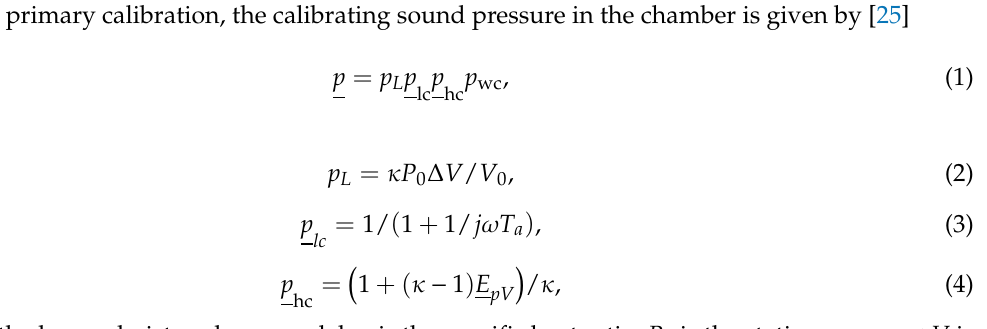
Figure 1. ( a ) The calibration characteristics of the laser pistonphone technique. ( b ) Prototype of a laser pistonphone.